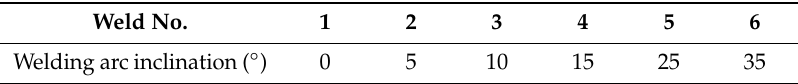
Table 2. Tilt angle of the welding